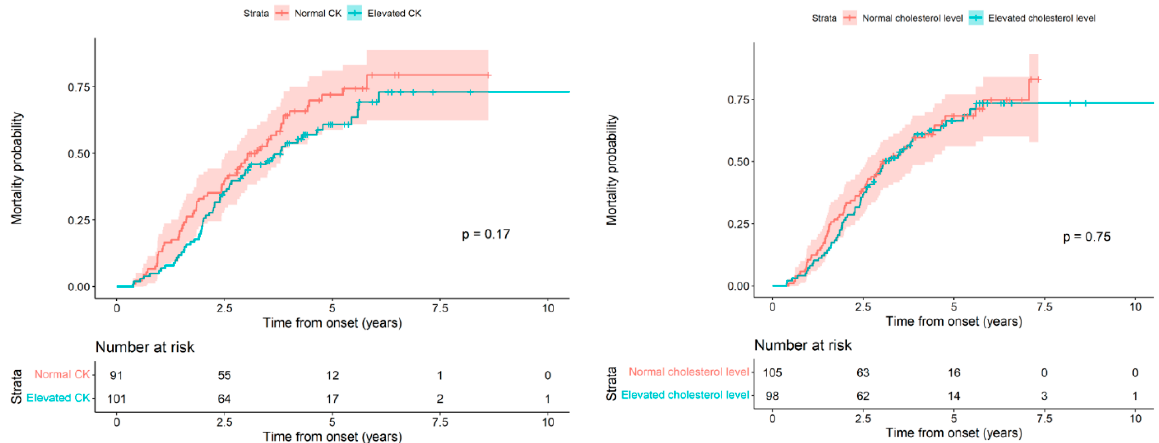
Figure 2. ( Left ) Mortality probability as a function of the follow-up time from onset, comparing levels of CK. The differences observed in the two survival curves according to the CK level do not allow us to reject the null hypothesis of equality (Log-rank test, p -value: 0.1731). ( Right ) Mortality probability as a function of the follow-up time from onset, comparing cholesterol levels. The differences observed of equality (Log-rank test, p -value: